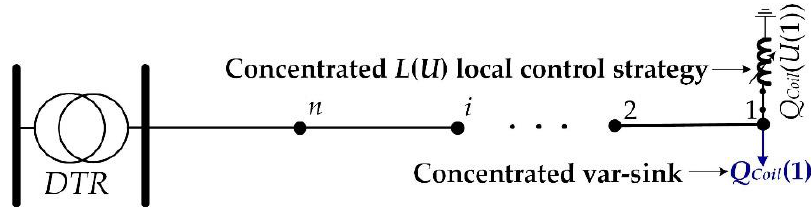
Figure 2. Overview of the concentrated L ( U ) local control strategy or rather concentrated var-sink.